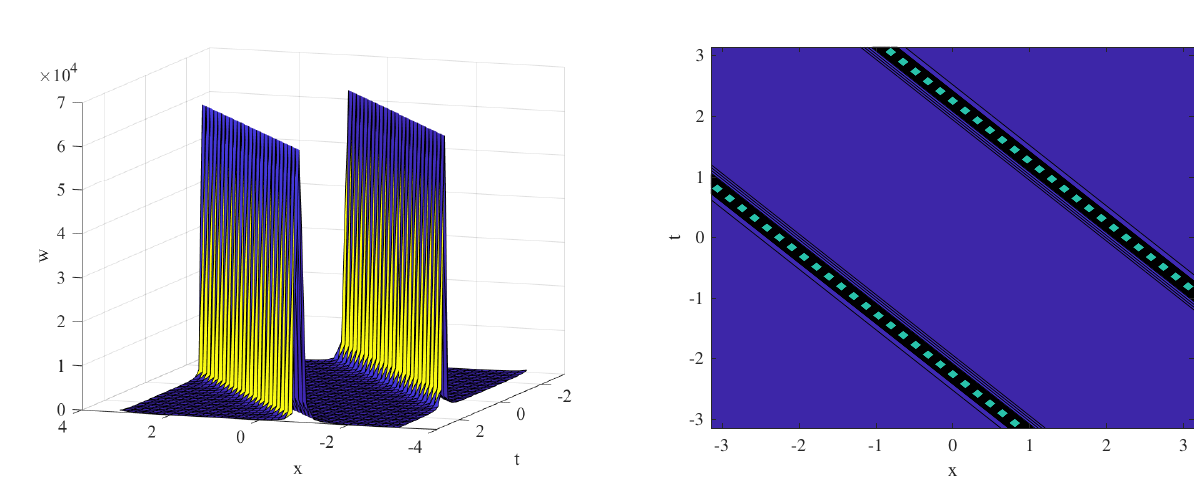
Figure 3. A traveling wave solution and a contour of solution (13) ( W 9 ( ξ )) under the parameters a 0 = 0.25, a 2 = a 4 =